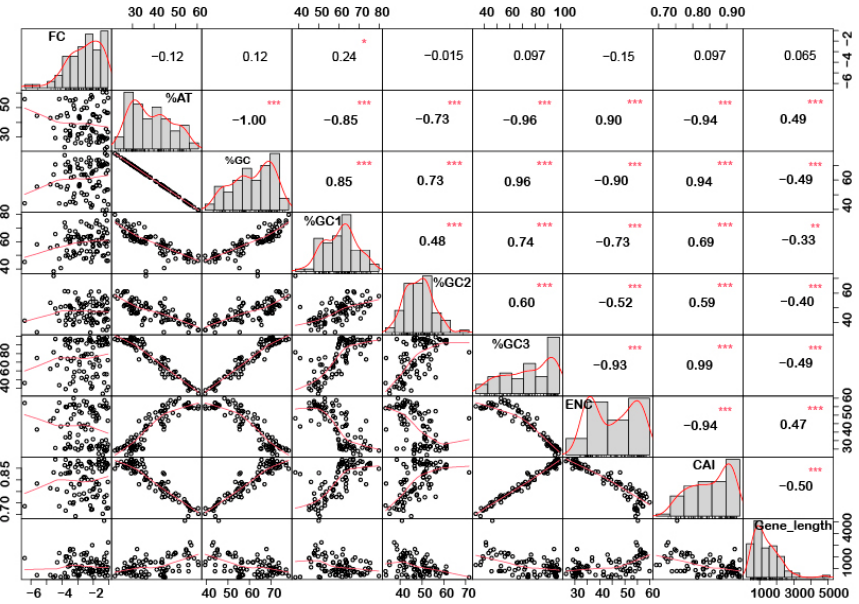
Figure 1. Correlation analysis among nucleotide composition, gene expression, gene length, ENC, and CAI of downregulated genes under abiotic stress. Based on the %GC, genes were grouped into two different categories, i.e., high and low %GC groups. %GC1 was positively correlated with gene expression, while %GC content (at the first, second and third codon positions) was negatively correlated with ENC and gene length while positively correlated with CAI. Asterisk indicate significant correlation, as *** with a p -value < 0.001, ** with p -value < 0.05 and * with a p -value < 0.01. FC = fold change; ENC = effective number of codons; CAI = codon adaptation index.